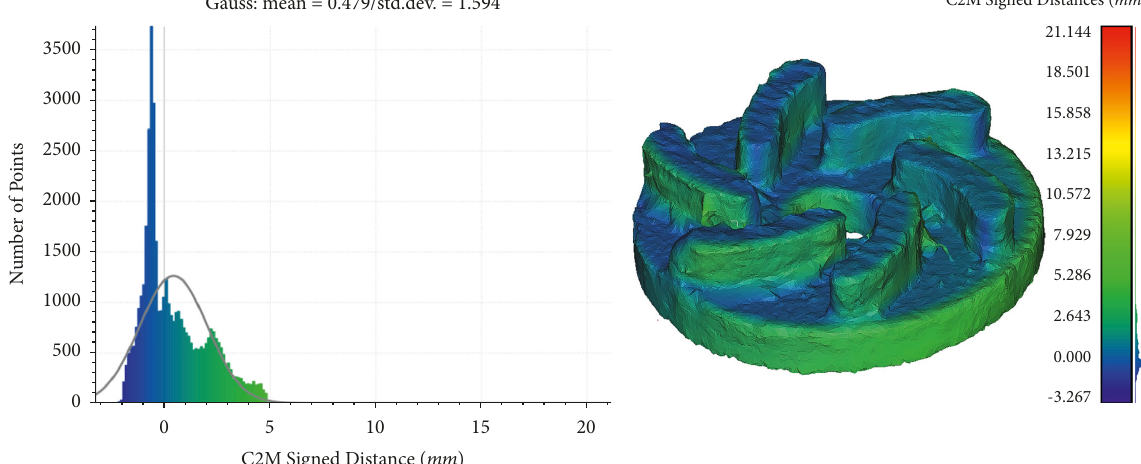
Figure 33: Cloud-to-mesh distance of near-net-shaped CAD model and scanned model of component realized through embedded substrate method.